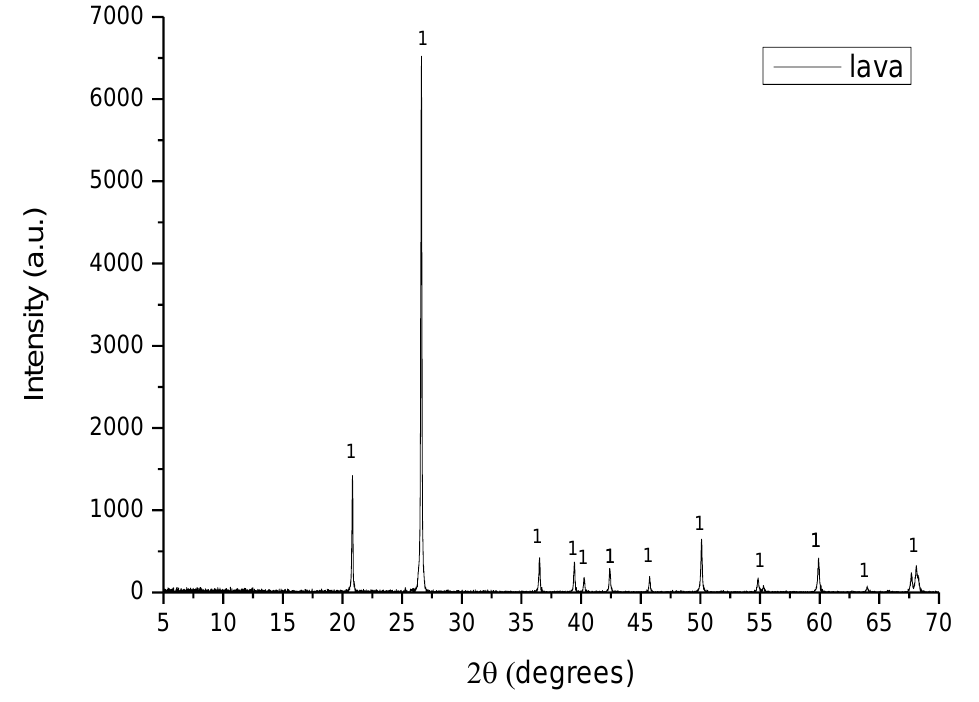
Figure 4. XRD pattern of lava where 1: quartz.